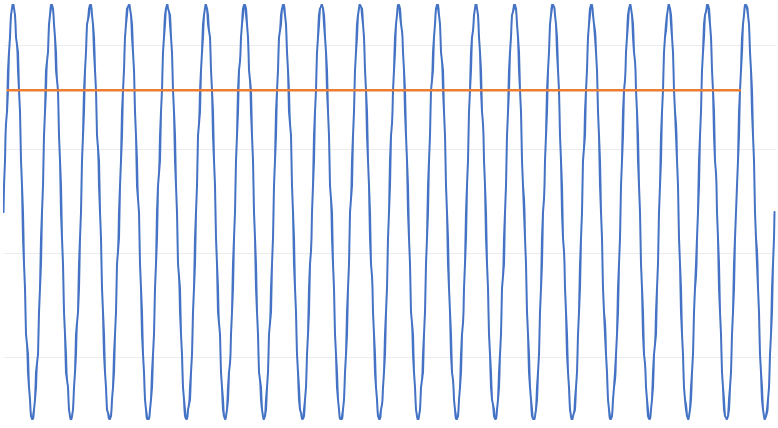
Figure 2. A 50 Hz sine wave sampled with 50 Hz and the resulting